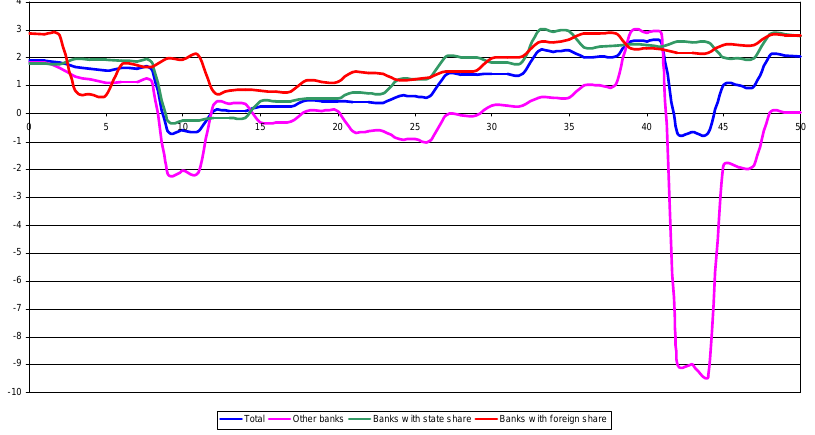
Figure 4. Dynamics of the financial stability index of all banks, state banks, banks with foreign participation and other banks